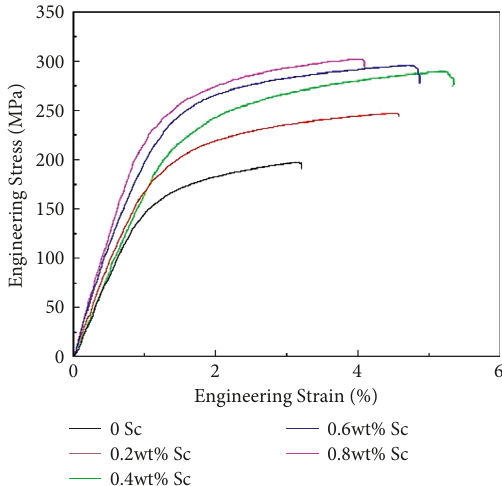
Figure 8: Stress-strain curves of composites with different Sc contents.